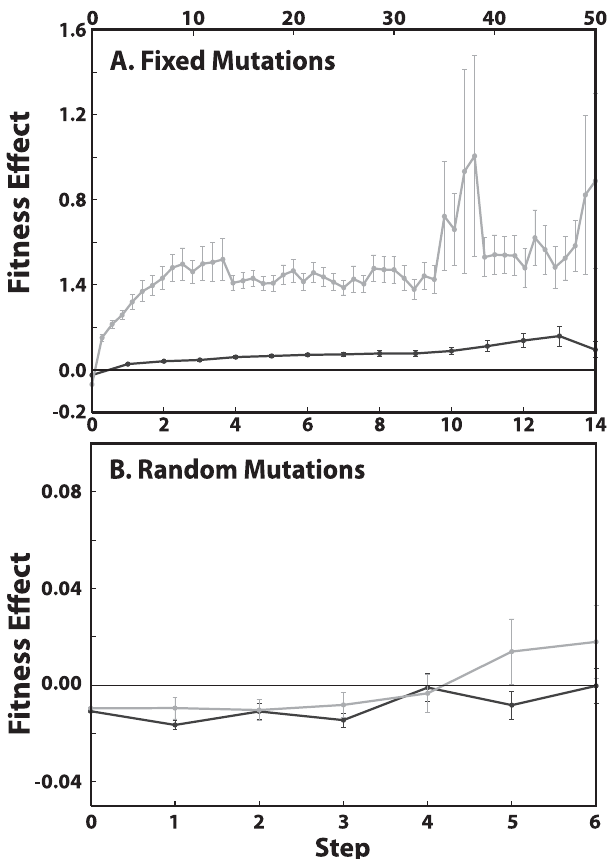
Figure 5. Fixed Deleterious Mutations Interact Positively with Subse- quent Substitutions, while Random Deleterious Mutations Generally Remain Deleterious (A) Mutations that were initially deleterious and ultimately fixed tended to become beneficial before their fixation. It is apparent that the largest increases in fitness occurred in the first few subsequent mutations. (B) In contrast, random deleterious mutations generally remained deleterious with subsequent mutations. In both graphs, the black lines correspond to U ¼ 0.08 and the light lines to U ¼ 0.32 (error bars represent one standard error of the mean). The horizontal lines separate the beneficial (above) and deleterious (below) fitness effects. The fitness , where W g 9 is the effect of a mutation is calculated as ð W g (cid:1) W g 9 Þ = W g 9 i i i i fitness effect of the descendent lineage without the fixed mutation and is the fitness effect of the descendent lineage with the fixed lineage. W g i DOI: